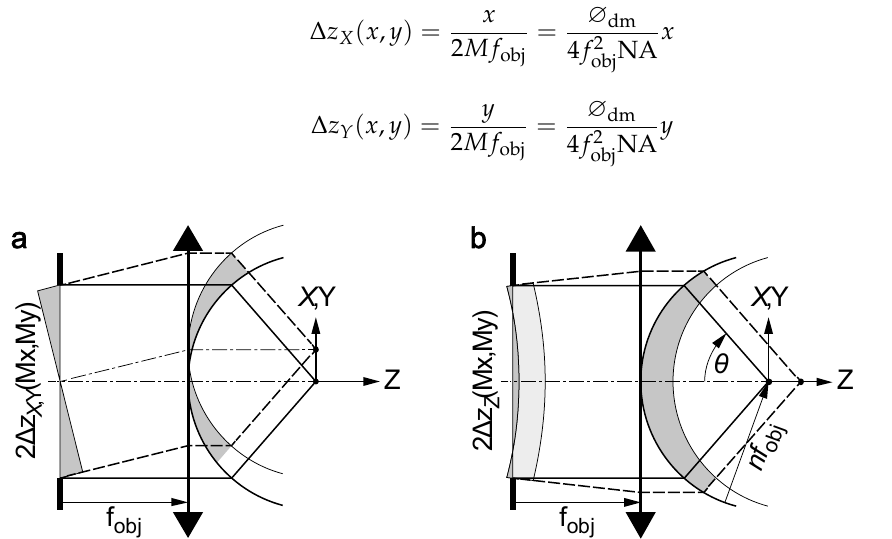
Figure 8. Illustration of the wavefront deformation for shifting the focus ( a ) in the lateral plane and ( b ) along the optical axis. The objective is simplified as a thin lens with flat principal plane on the aperture side, coinciding with the lens, and spherical principal plane on the object side, centered on the focus. An offset (light gray) is trimmed from the characteristic shape ∆ z Z (dark gray) to obtain minimal displacements.